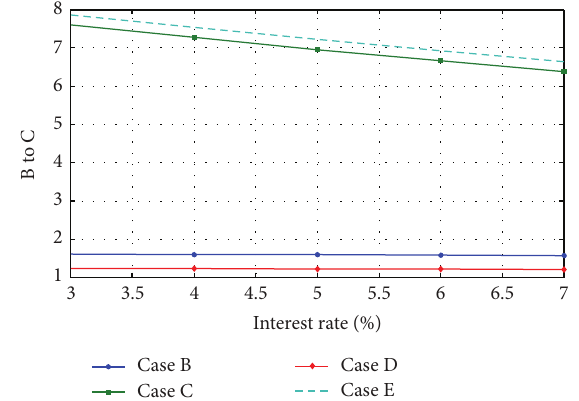
Figure 8: Effect of interest rate on Benefit-to-Cost Ratio for four different cases.